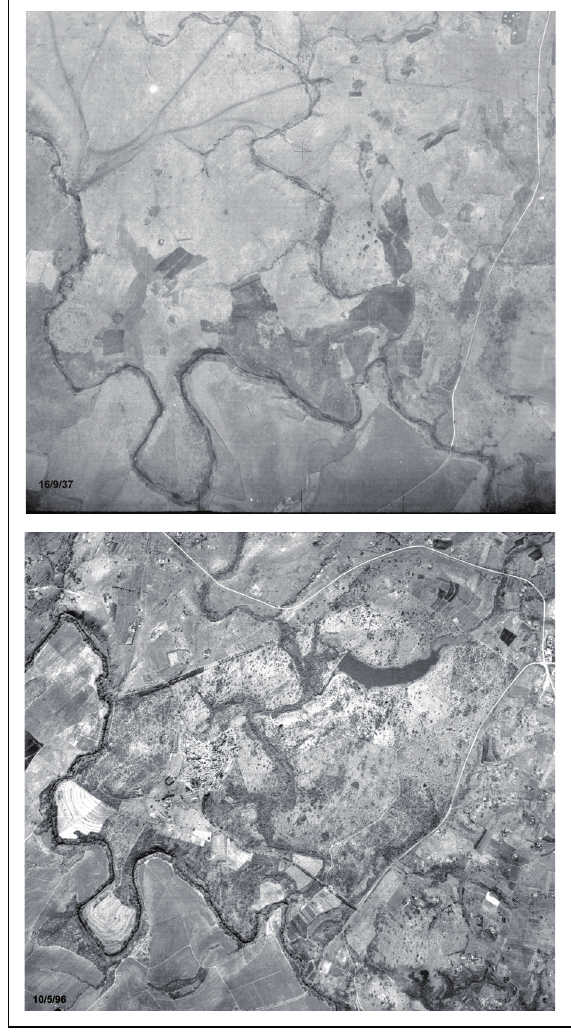
Figure 1 Aerial photographs of the farm of the Owen Sitole College of Agriculture during (a) 1937 and (b) 1996